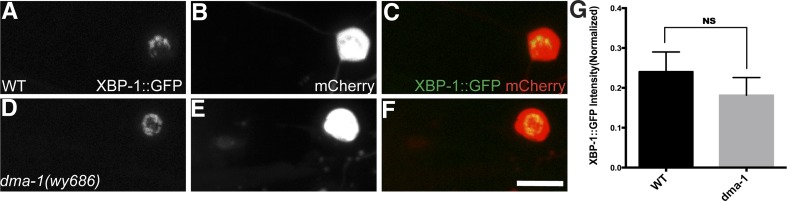
The UPR in unbranched PVC neurons does not depend on DMA-1.The UPR activity in WT (A to C) and dma-1 mutants (D to F). UPR activity is measured by XBP-1::GFP brightness while the intensity of mCherry is used to normalize for transgene expression level. Scale bar, 5 μm. (G) Quantification of the normalized UPR activity in PVC in (A to F). Error bars show mean ± s.e.m. n = 20. NS, not significant, t-test.